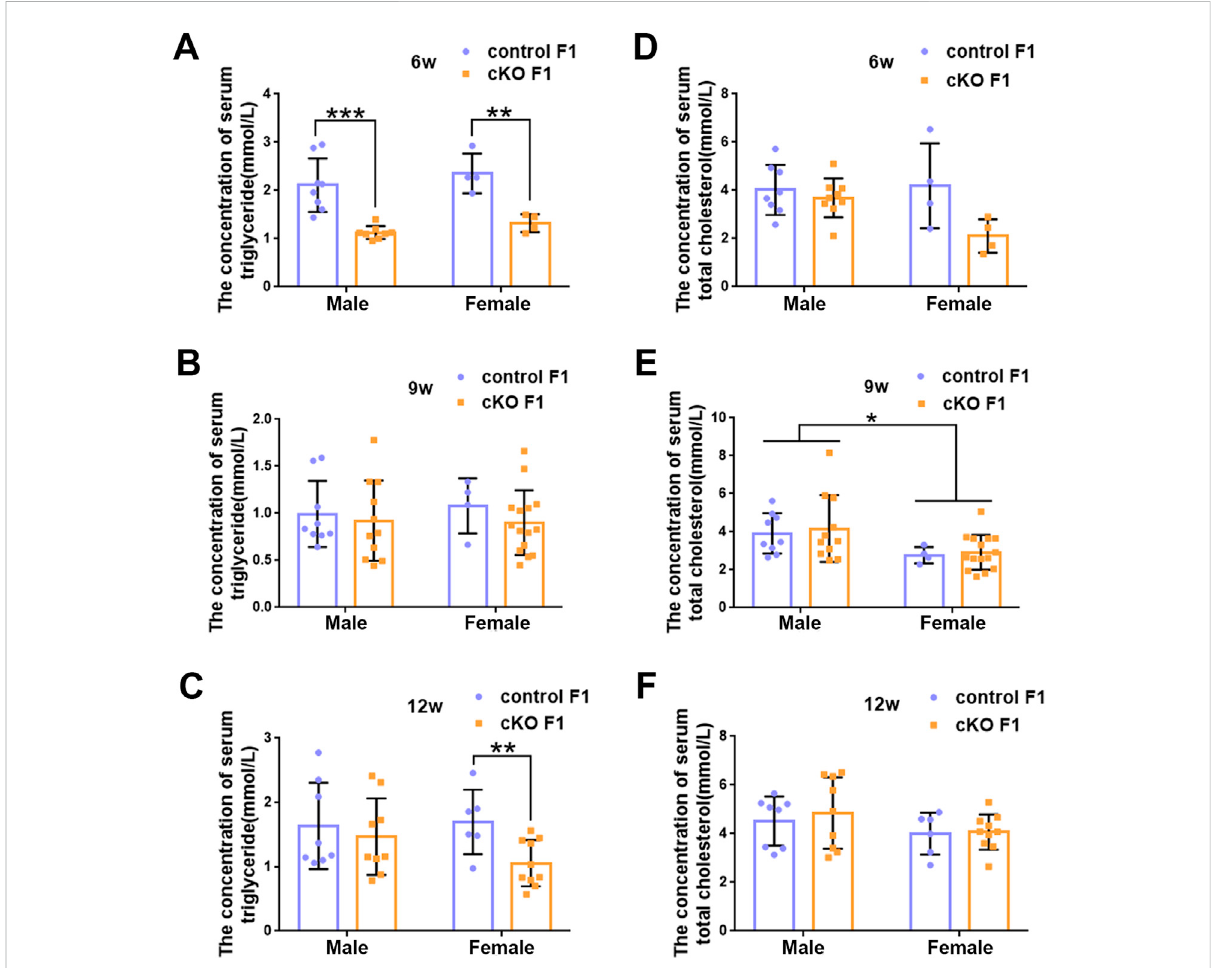
FIGURE 5 The concentration of serum lipid was measured in F1 generation of endometrial DNMT3B conditional knockout female mice (A – C) Serum triglyceridelevelsweremeasuredincontrolandcKOF1male(n=8 – 11)andfemale(n=4 – 15)miceat6-weeks,9-weeksand12-weeksofage. (D – F)